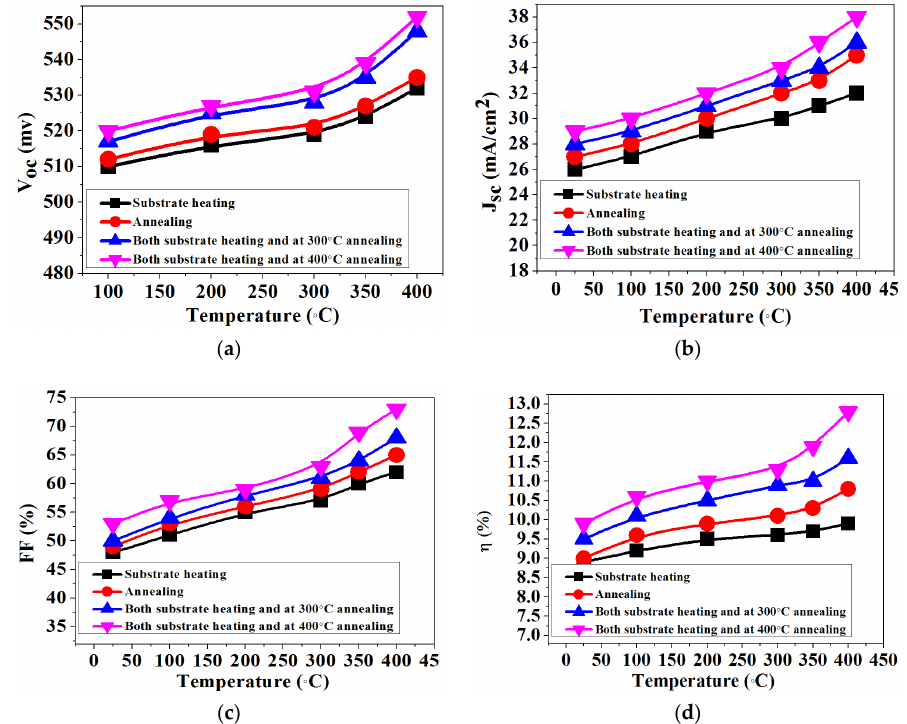
Figure 6. I–V parameters of copper indium gallium selenium (CIGS) thin-film solar cells as a function of temperature of Mo electrodes heated in three different modes: ( a ) change of the open circuit voltage (Voc) with different temperature; ( b ) change of the short circuit current density (Jsc) with different temperature; ( c ) change of the fill factor (FF) with different temperature; and ( d ) change of the photo-conversion efficiency( η ) with different temperature.